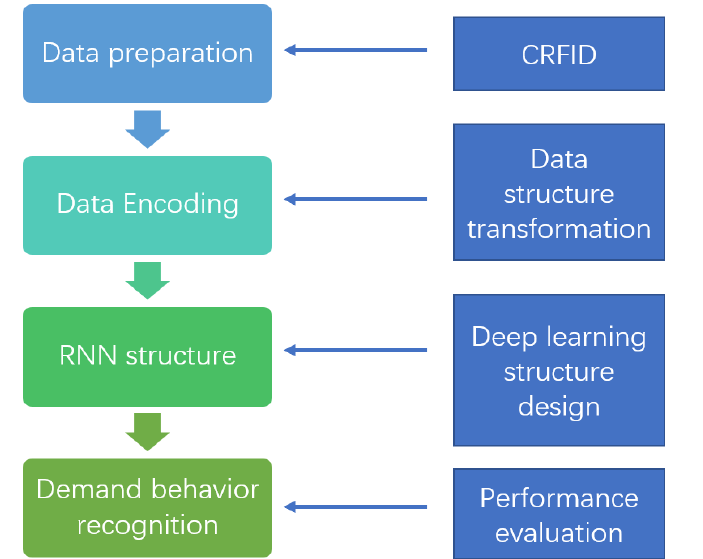
Figure 6. The workflow of the personalized activities learning system [97].